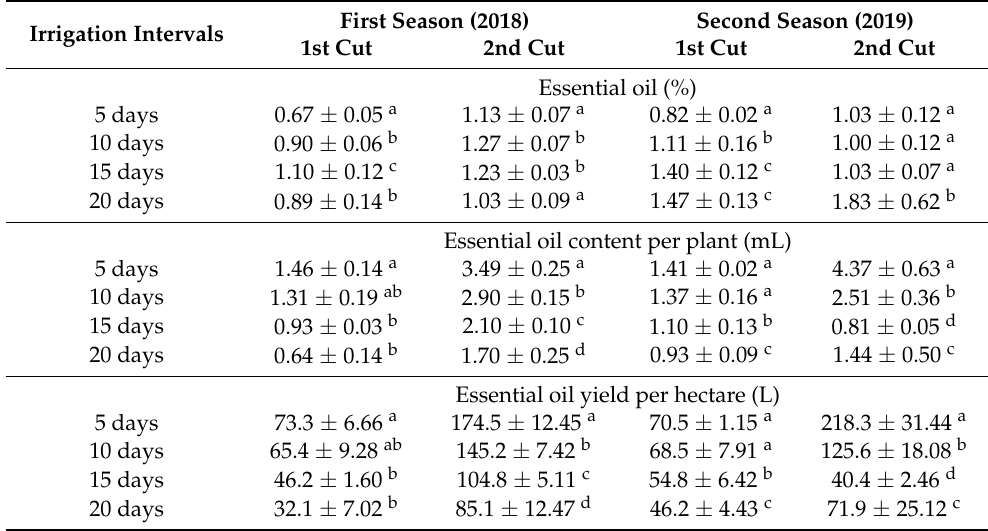
Table 3. Influence of irrigation intervals on essential oil (%), essential oil content per plant, and essential oil yield per hectare in the 1st and 2nd harvest of 2018 and 2019 seasons. Irrigation Intervals